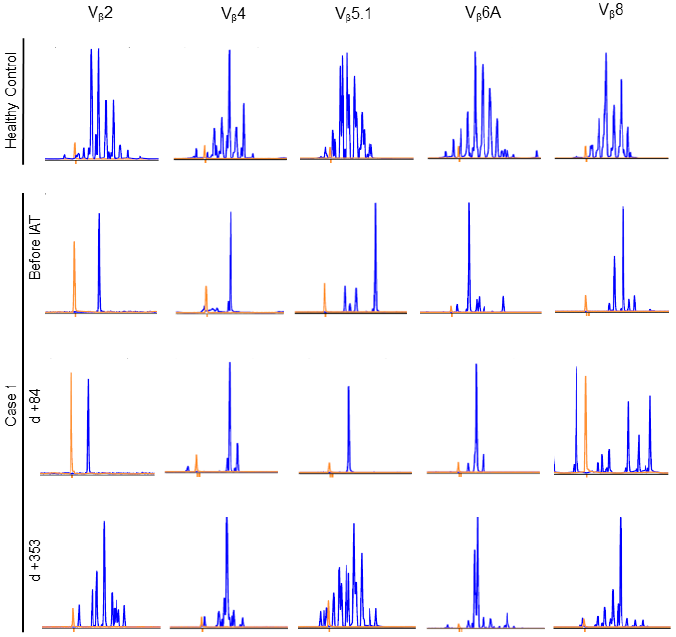
Figure 6. T cell receptor repertoire in peripheral blood assessed by V β -spectratyping in case 1.